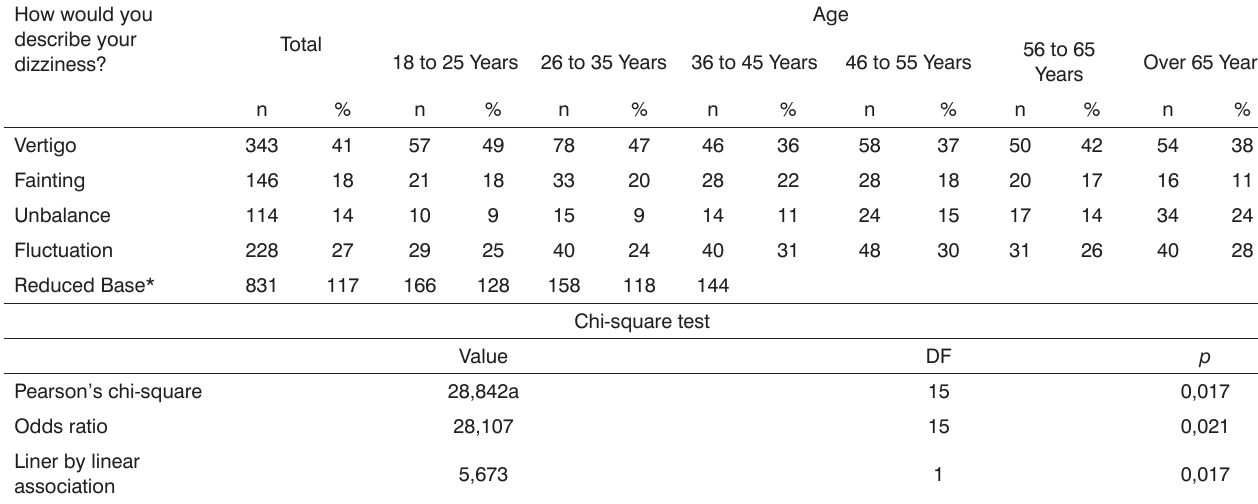
n: Sample size; % Percentage of the sample; DF: Difference; p : Statistical significance (two-tails); a: 2 cells (14.3%) expected count less than 5. The minimum expected count is Table 4. Distribution of the various descriptions of the "feeling dizzy" complaint (n = 831) according to age groups in the popu- lation of the city of São